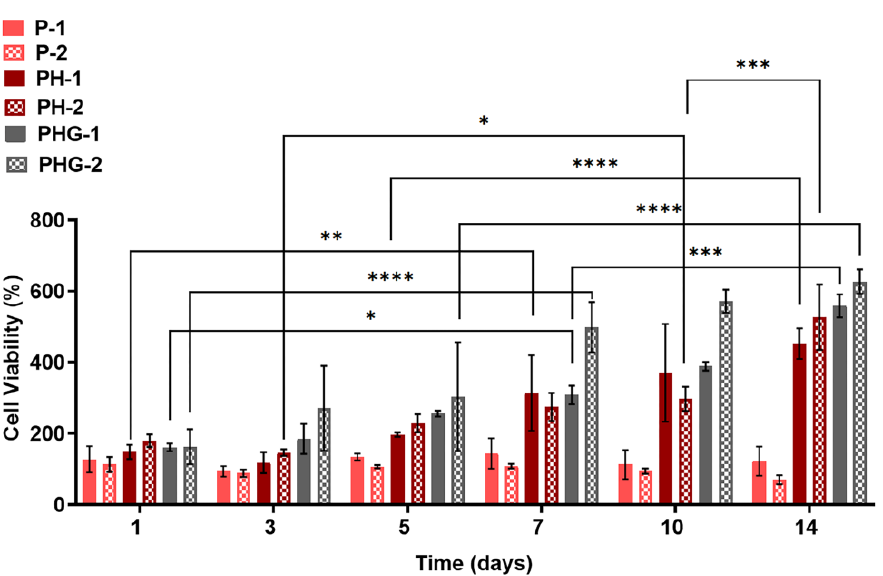
Figure 9. Metabolic activity of osteoblast cells cultured on P, PH, PHG membranes for up to 14 days based on alamarBlue assay. Statistical significance; * p ≤ 0.05, ** p ≤ 0.01, *** p ≤ 0.001, **** p ≤ 0.0001.